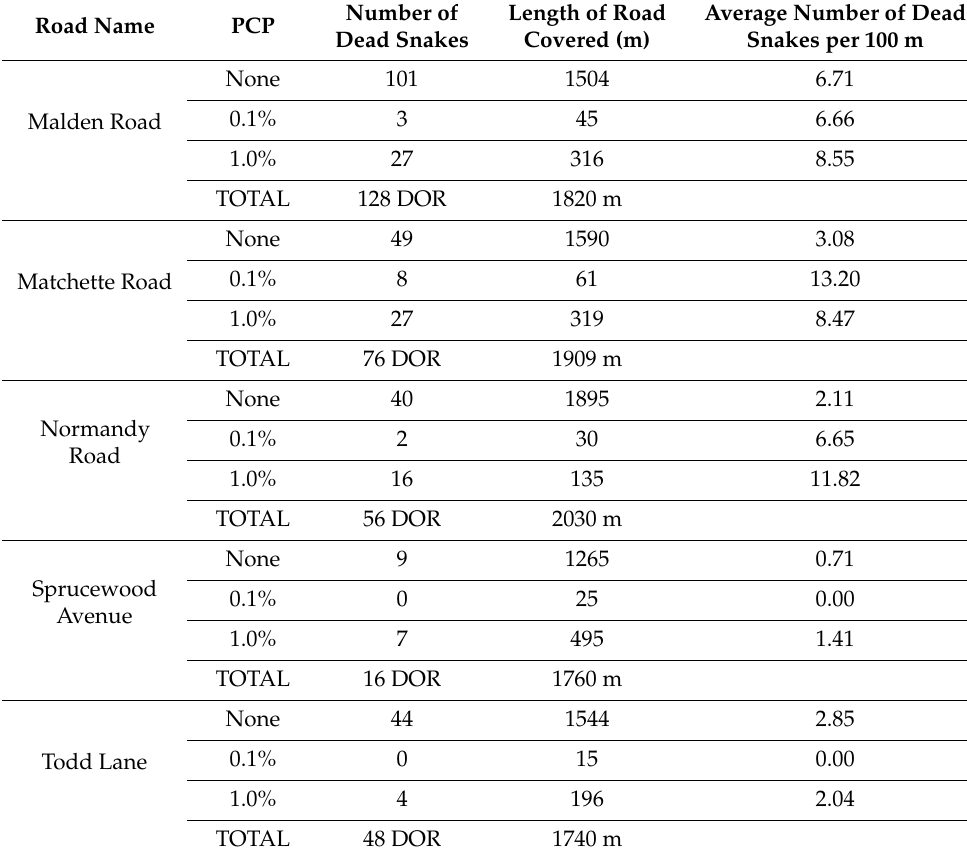
Table 3. Number of dead snakes observed inside and outside the bounds of the 0.1% and 1.0% permeability swaths where PCP1, PCP2, PCP3, and PCP5 intersect five roads, using a subset of snake road mortality data (n = 324) collected systematically from 2010–2013 [46]. Results are